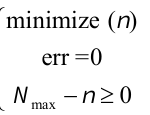
Figure 3. Impedance seen from the input of the line for a -20 dB error